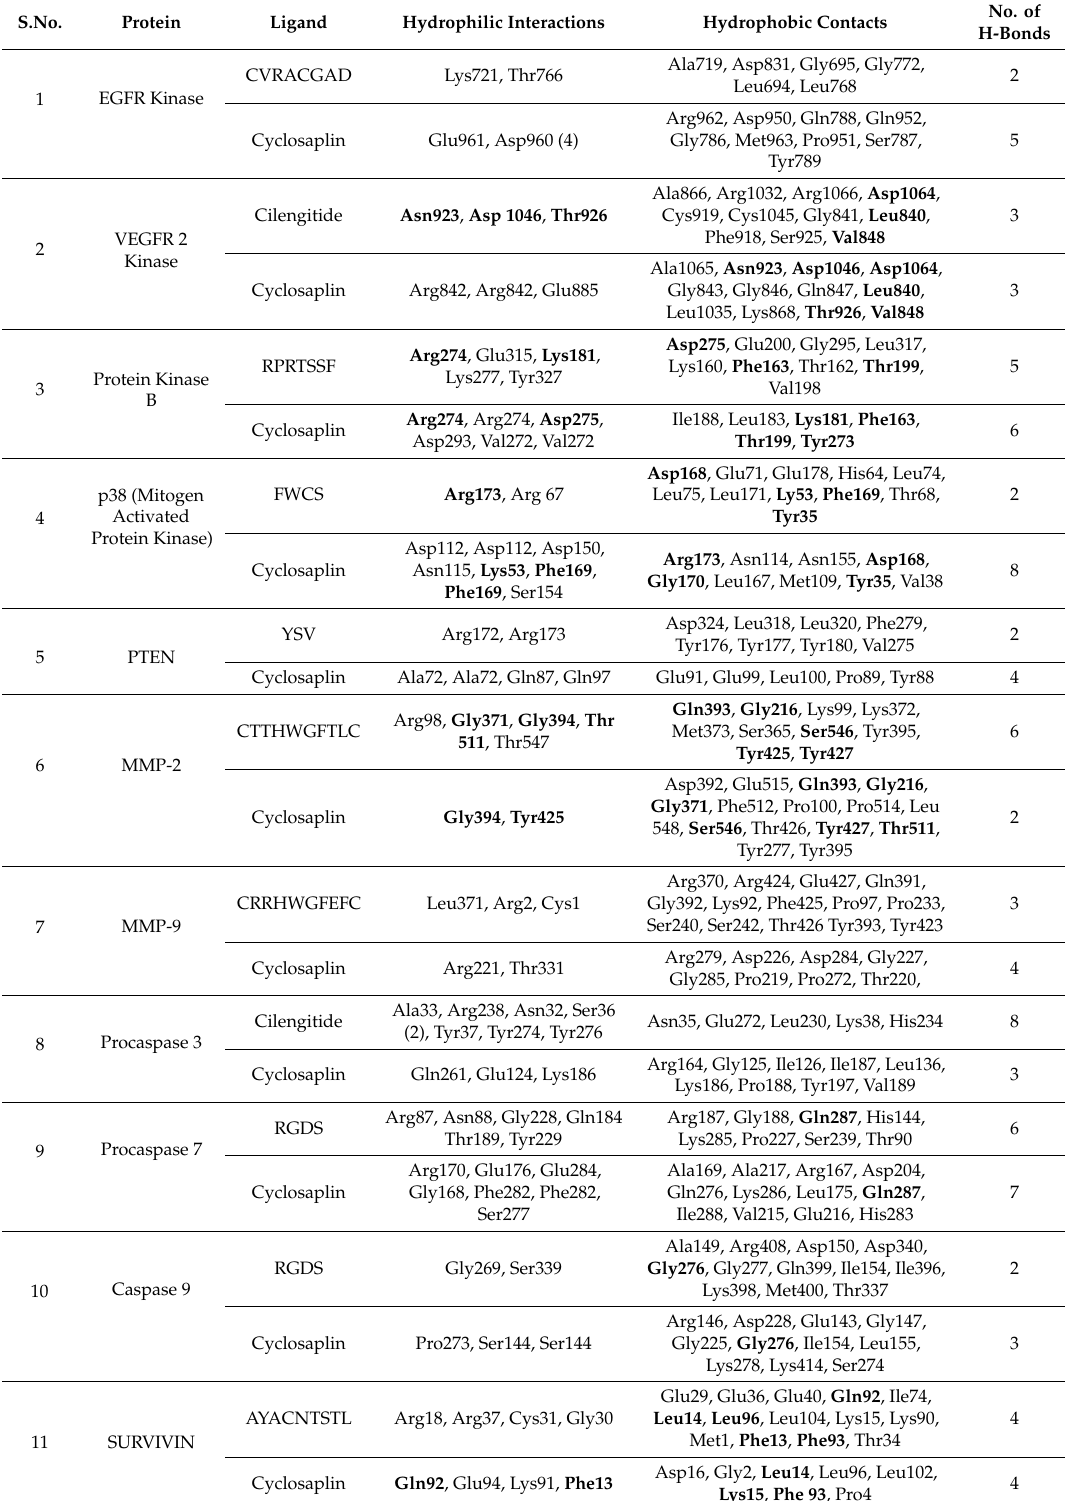
Table 5. Molecular interactions of ligands with amino acids of proteins (amino acids showing similar interactions are marked in bold; black = cis similarity; red = trans